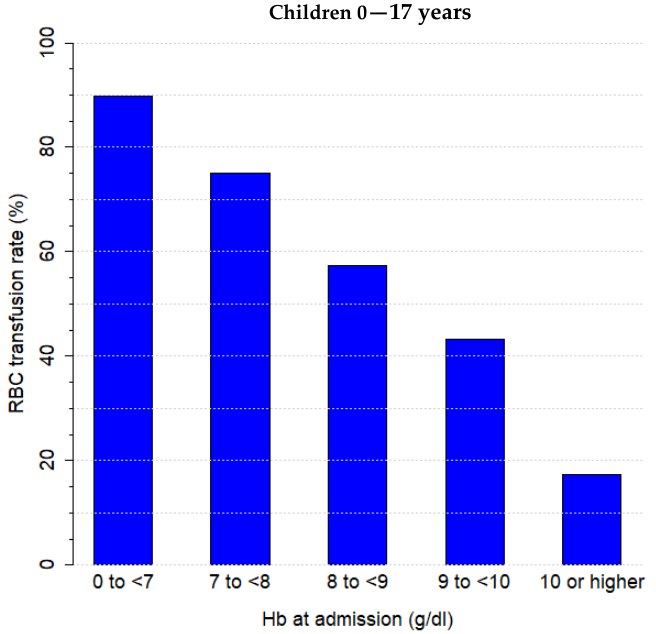
Figure 2. Proportion of patients transfused according to haemoglobin threshold. RBC transfusion rate (%) dependence on Hb value at admission (g/dL). Children who were transfused with RBC had a higher mortality rate (7.1% versus 0.1%) and a longer hospital LOS (median 32 versus 2 days, mean 42.0 vs. 4.4 days) than non-transfused children.